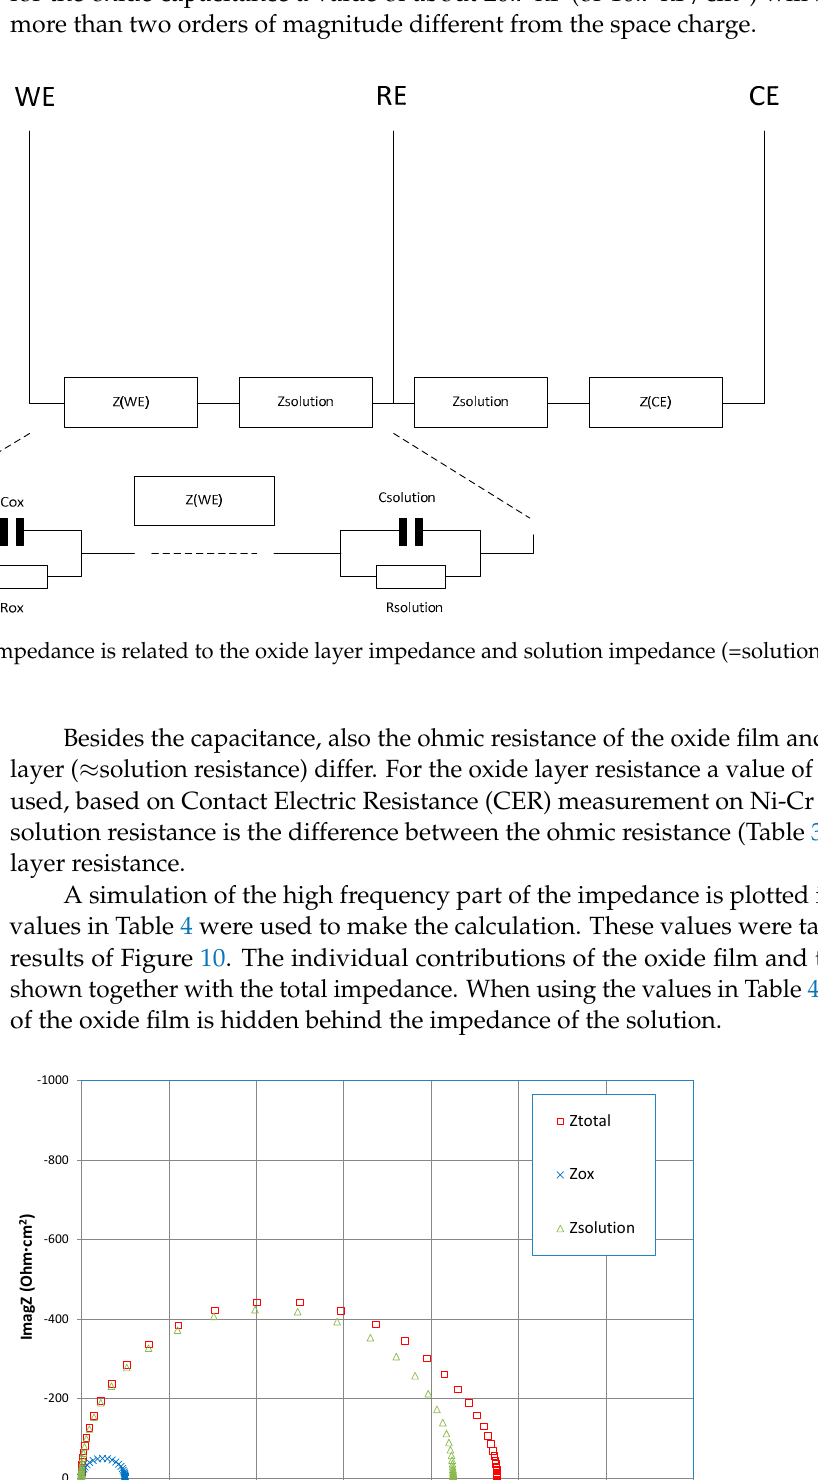
Figure 9. High frequency part of the impedance: oxide layer (blue cross), solution (green dash) and total high frequency impedance (red square).